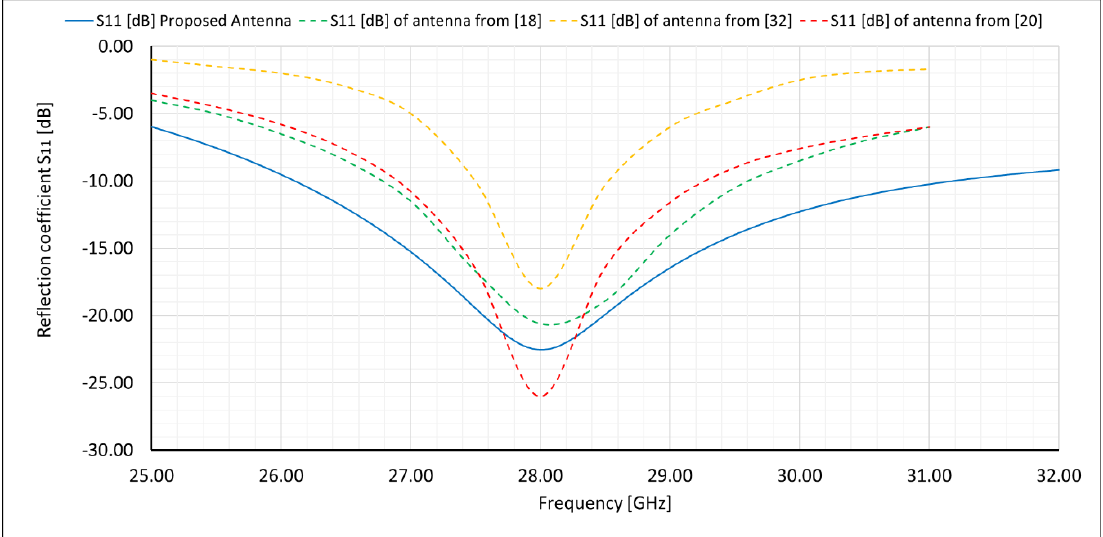
Figure 13. The reflection coefficient as a function of frequency for the proposed antenna and antennas from other works. Electronics 2020 , 9 , x FOR PEER REVIEW